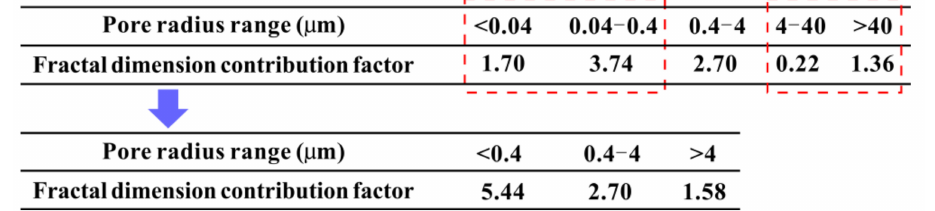
Figure 13. Fractal dimension contribution factors of different grades of